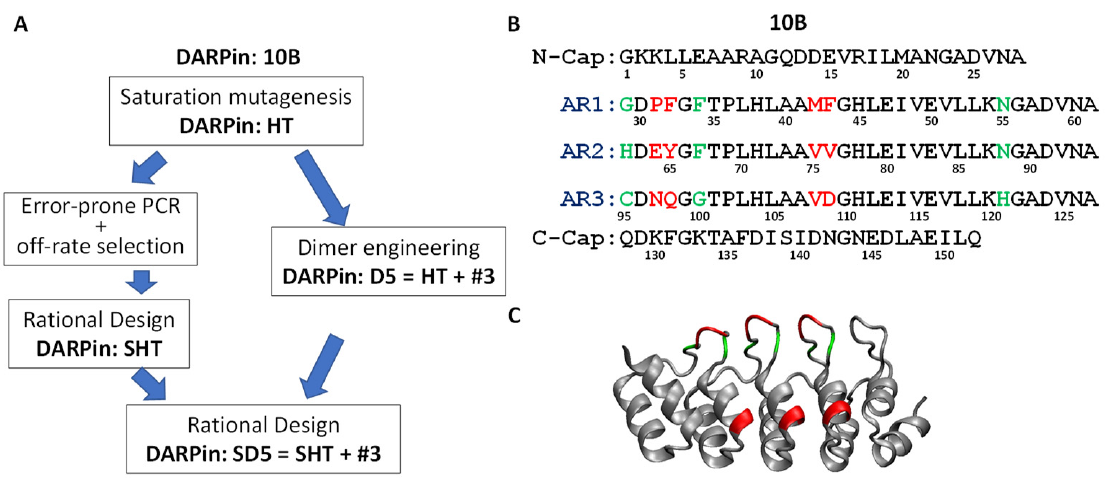
Figure 2. ( A ) Schematic of the affinity maturation strategy. Sequence ( B ) and homology model ( C ) of DARPin 10B. Both green and red residues were randomized in the original DARPin library, and the red residues were subjected to saturation mutagenesis.